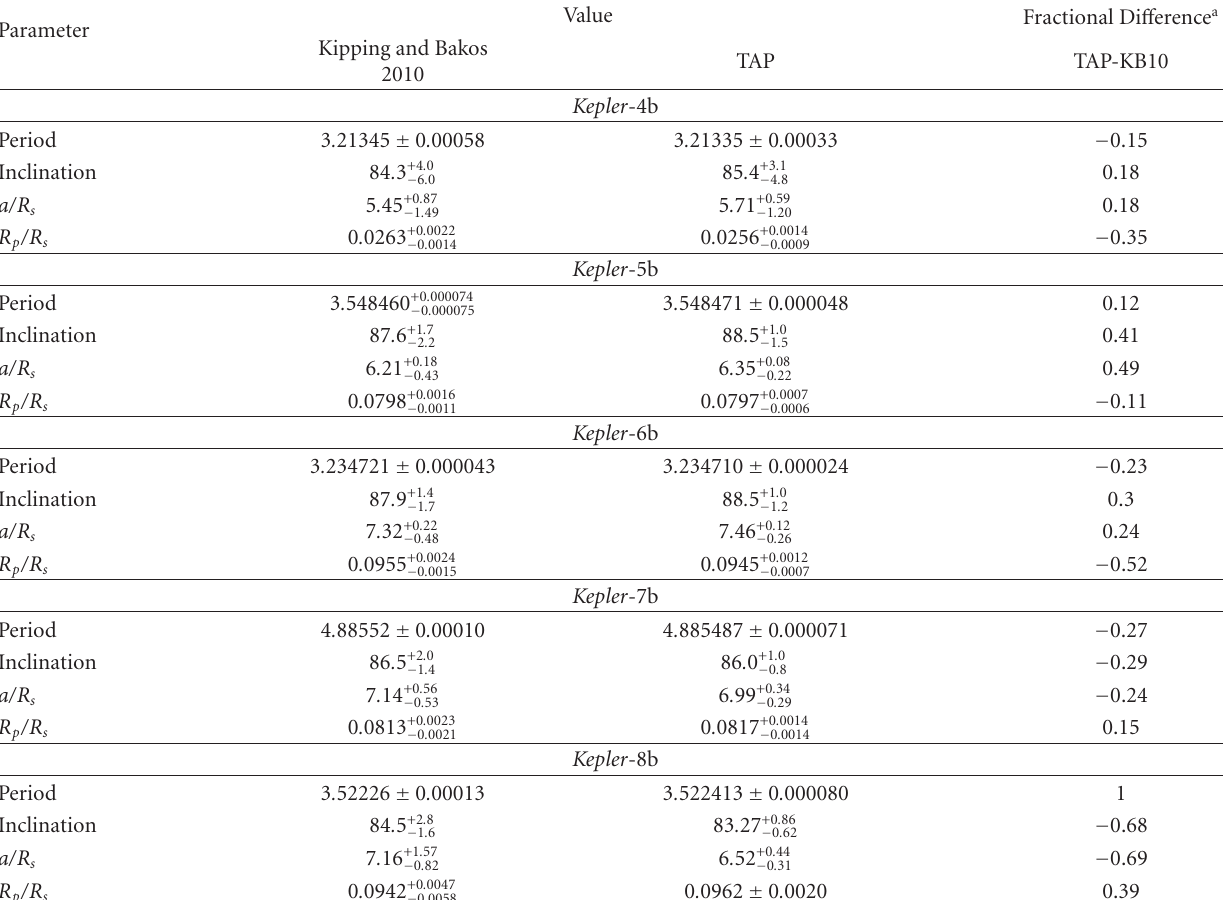
Table 5: Analysis of Kepler -4b through